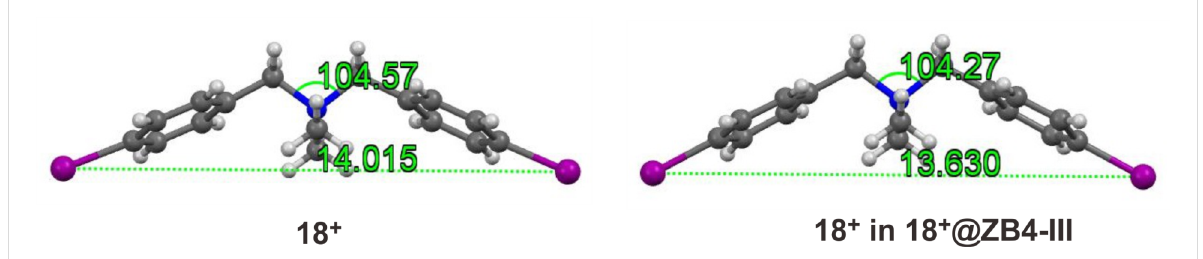
Figure 4: X-ray single crystal structures of 18 + @ZB4-III and 18 + in 18 + @ZB4-III .